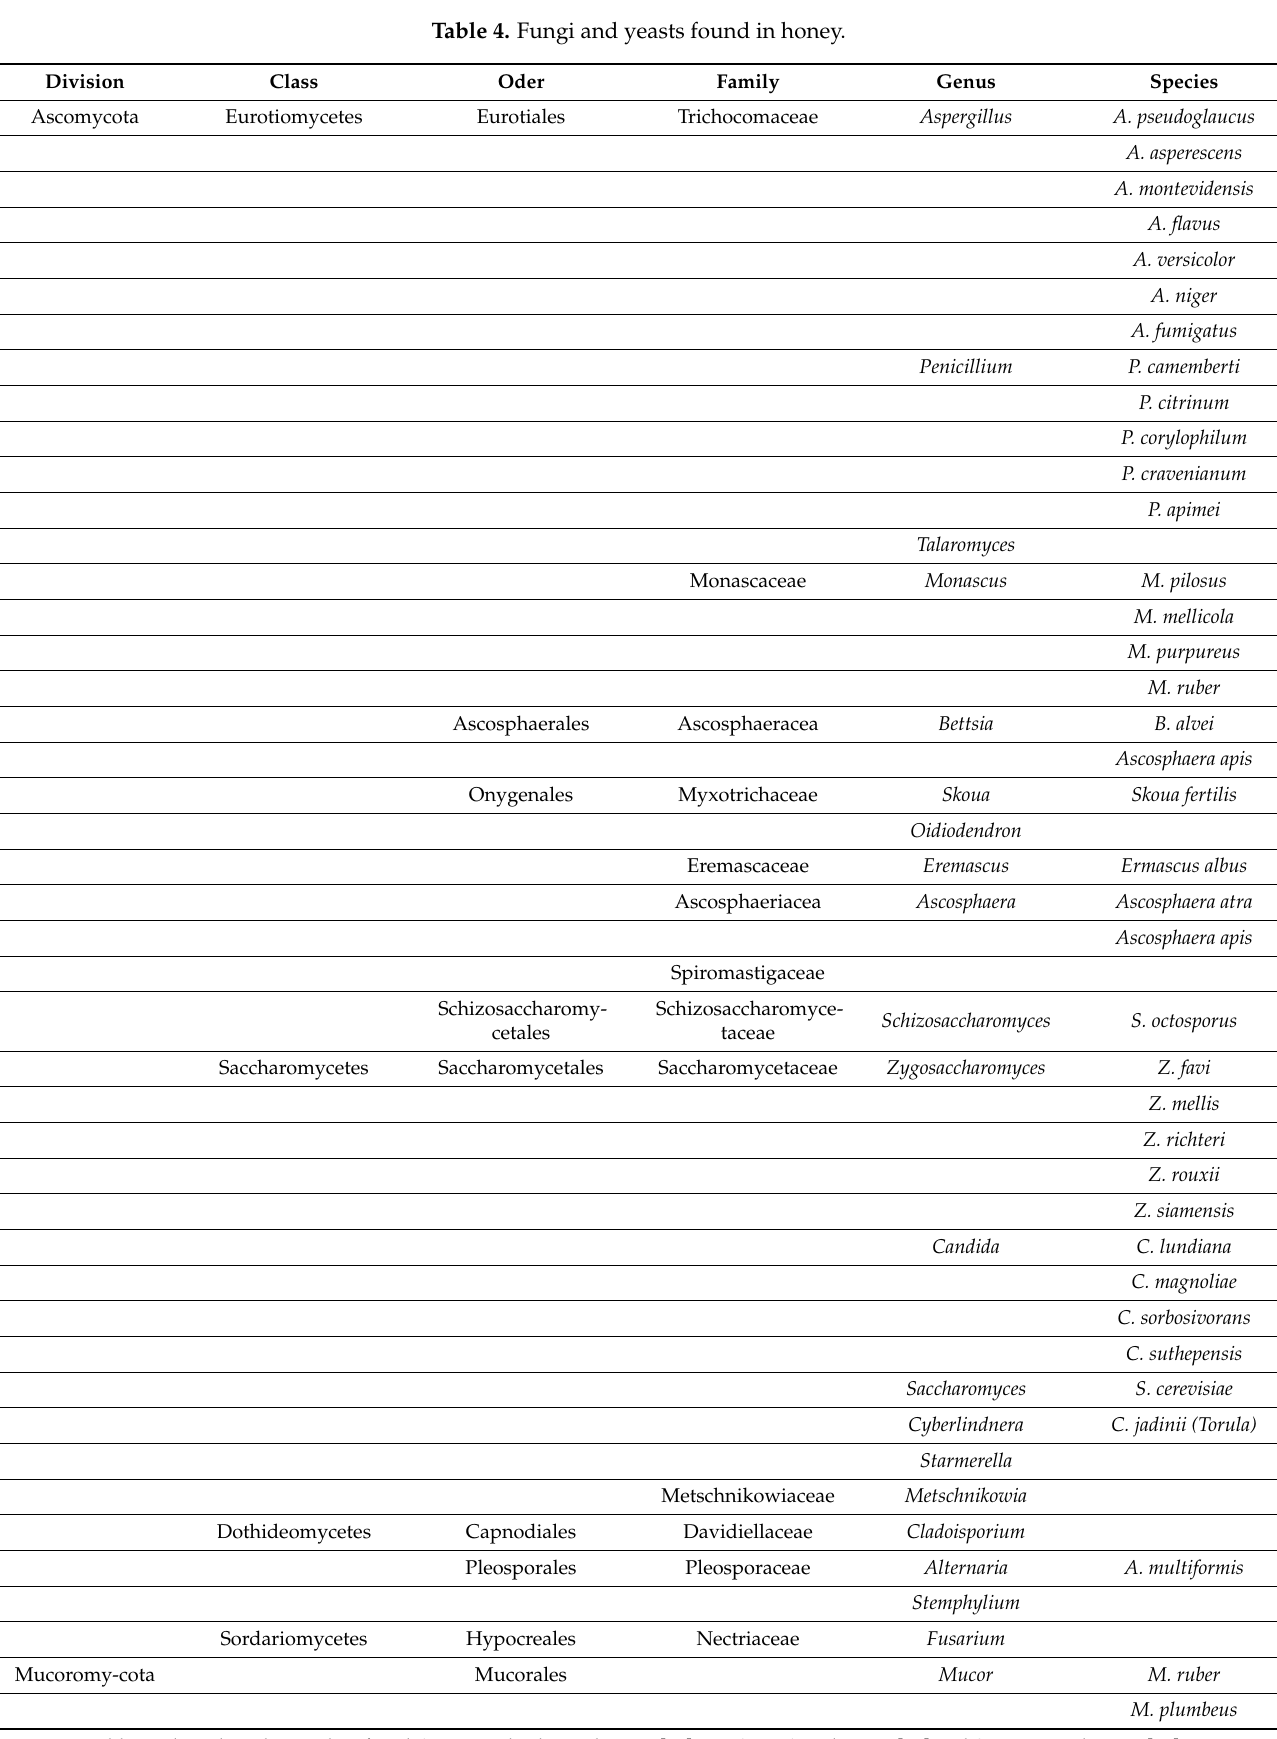
Table 4 is based on the results of Rodr í guez-Andrade, et al., 2019 [67], Kaˇc á niov á et al., 2012 [68] and Sinacori et al., 2014